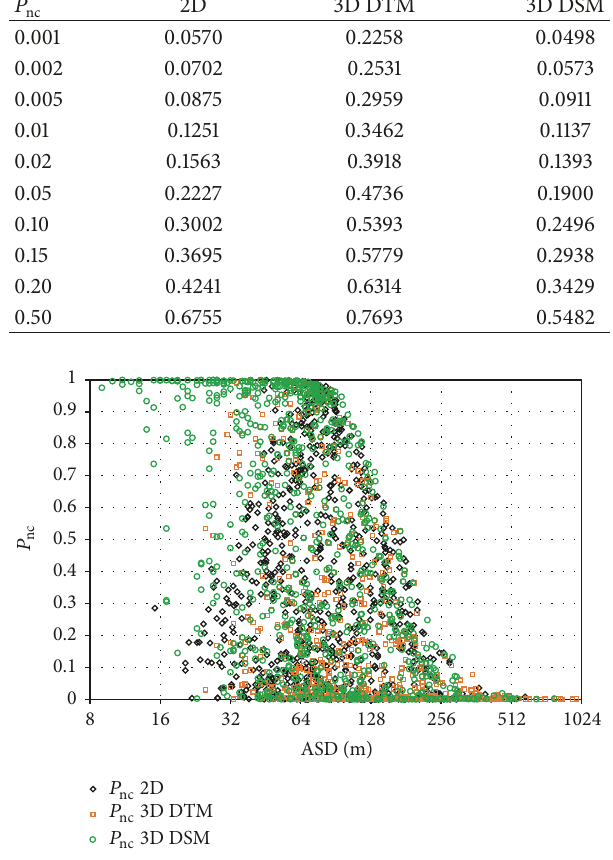
Figure 5: Scatter plot of ASD values and 𝑃